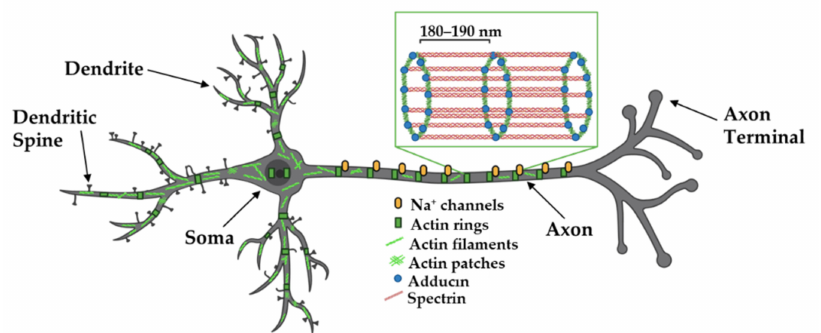
Figure 3. Organization of actin in axons and dendrites. Actin filaments, spectrin, and adducin form ring-like structures around the axon shaft, dendrites, and soma where they are thought to provide structural support and organize axonal Na + channels. Evidence suggests segments of dendrites are either dominated by rings or linear filaments and that neuronal activity causes changes in these structures. Adapted from “Pyramidal Neuron (dendritic spines low)”, by https://BioRender.com (accessed on 26 January 2022) (2020). Created and retrieved from https://app.biorender.com/ biorender-templates (accessed on 26 January 2022). Actin-adducin-spectrin image adapted from Xu et al.,